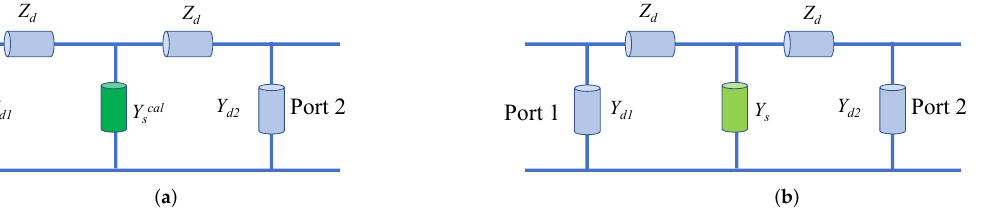
Figure 3. Equivalent circuit model with material in the unstretched state (calibration circuit) ( a ) and with material in stretched state ( b ).